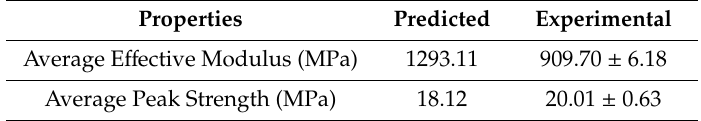
Table 1. Compressive properties of Kagome structures fabricated by selective laser